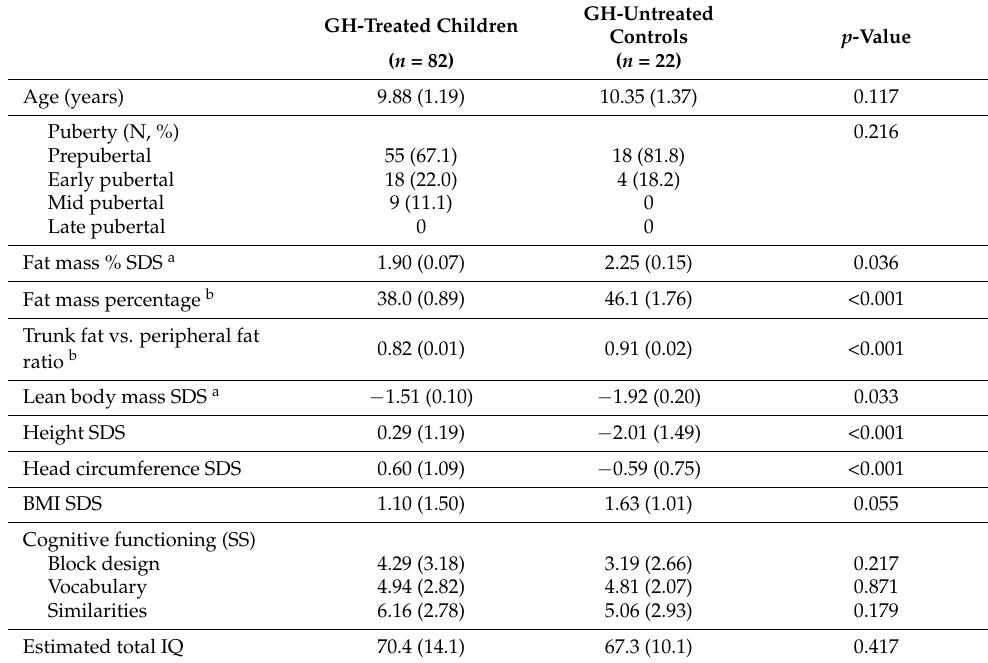
Table 2. Results after 8 years of GH treatment compared to GH-untreated